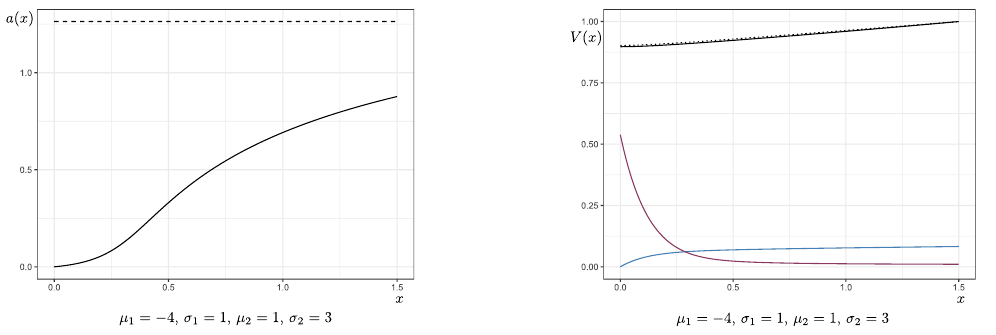
Figure 1. ( Left ) a ( x ) (solid) is bounded from above by a constant ¯ a 0 (dashed). ( Right ) V ( x ) (solid, black), V (cid:48) ( x ) (blue), V (cid:48)(cid:48) ( x ) (red). The dotted line represents the Laplace transform under the strategy of no